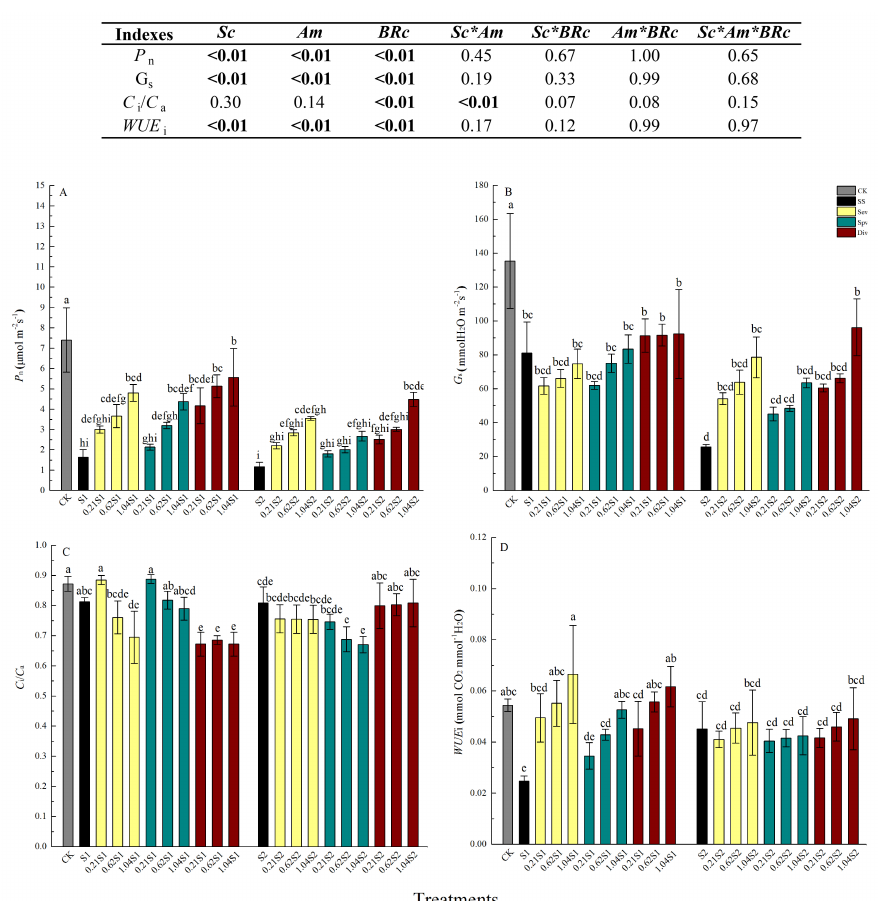
Figure 1. Effects of exogenous 24-epibrassinolide (24-epiBL) on ( A ) net photosynthetic rate ( P n ), ( B ) stomatal conductance ( G s ), ( C ) ratio of intercellular to ambient CO 2 concentration ( C i / C a ), and ( D ) intrinsic water use efficiency ( WUE i ) of leaves of black locust seedlings at 100 (SS-S1) or 200 (SS-S2) mM NaCl. Each panel shows data for the zero salt control (CK, grey bar) and salt-stressed control (S1 & S2, black bar) and salt-stressed plants pretreated with either 0.21, 0.62, or 1.04 mM 24-epiBL by seed soaking (Sew, yellow bars), foliar spraying (Spw, green bars), or roots dipping (Diw, red bars). Each bar represents the mean ( ± standard deviation (SE)) of three replicates. Different letters above the bars show significant differences between means within each panel ( p < 0.05). The p values are for the salt concentration effect ( Sc ), the 24-epiBL application method effect ( Am ), the 24-epiBL application concentration effect ( BRc ), the interaction effect between the salt concentration and 24-epiBL application method ( Sc*Am ), the interaction effect between the salt concentration and 24-epiBL application concentration ( Sc*BRc ), the interaction effect between the 24-epiBL application method and 24-epiBL application concentration ( Am*BRc ), and the interaction effect among the salt concentration, 24-epiBL application method, and 24-epiBL application concentration ( Sc*Am*BRc ), respectively. The significant effect was p < 0.05. Control (CK); 100 mM NaCl treatment (S1); 200 mM NaCl treatment (S2); treatments with 24-epiBL (0.21, 0.62, 1.04 µ M) under 100 mM NaCl stress (0.21S1, 0.62S1, 1.04S1); treatments with 24-epiBL (0.21, 0.62, 1.04 µ M) under 200 mM NaCl stress (0.21S2, 0.62S2,